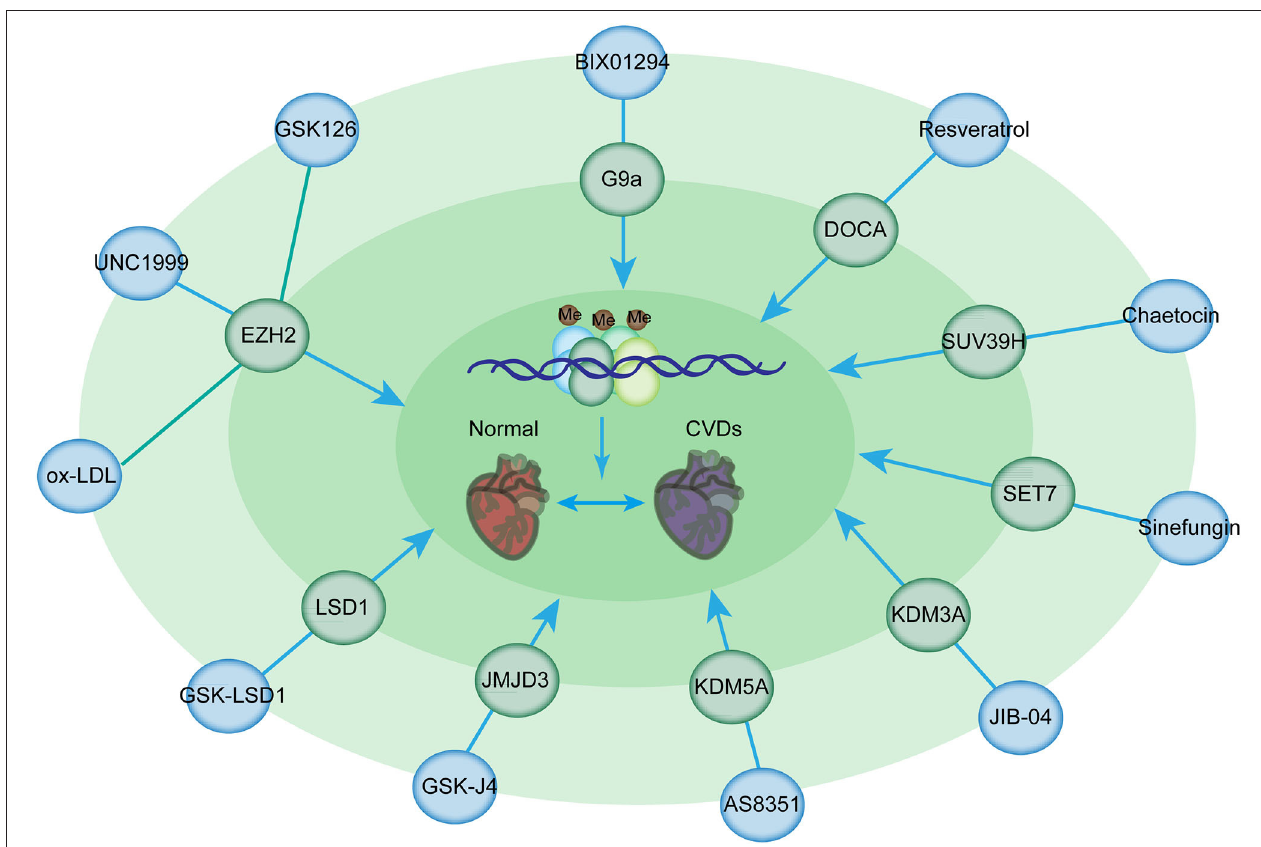
FIGURE 4 | Histone methylation-modifying inhibitors and their targets for the prevention of CVDs. Histone methylation-modifying inhibitors are indicated in bold together with their respective targets. Each compound specifically targets the enzymes involved in methylation regulation, thus affecting chromatin accessibility and binding of transcription factors critical for CVDs. These alterations modulate the expression of downstream genes in